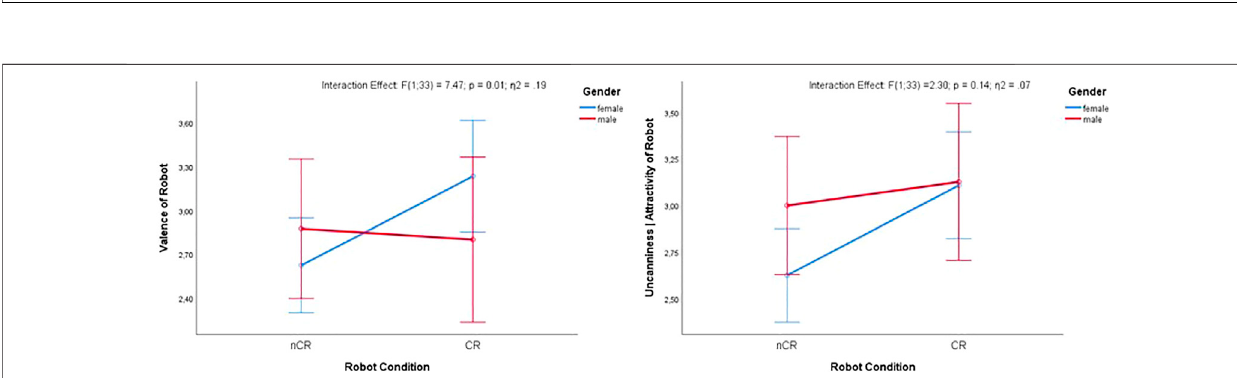
Frontiers in Virtual Reality |